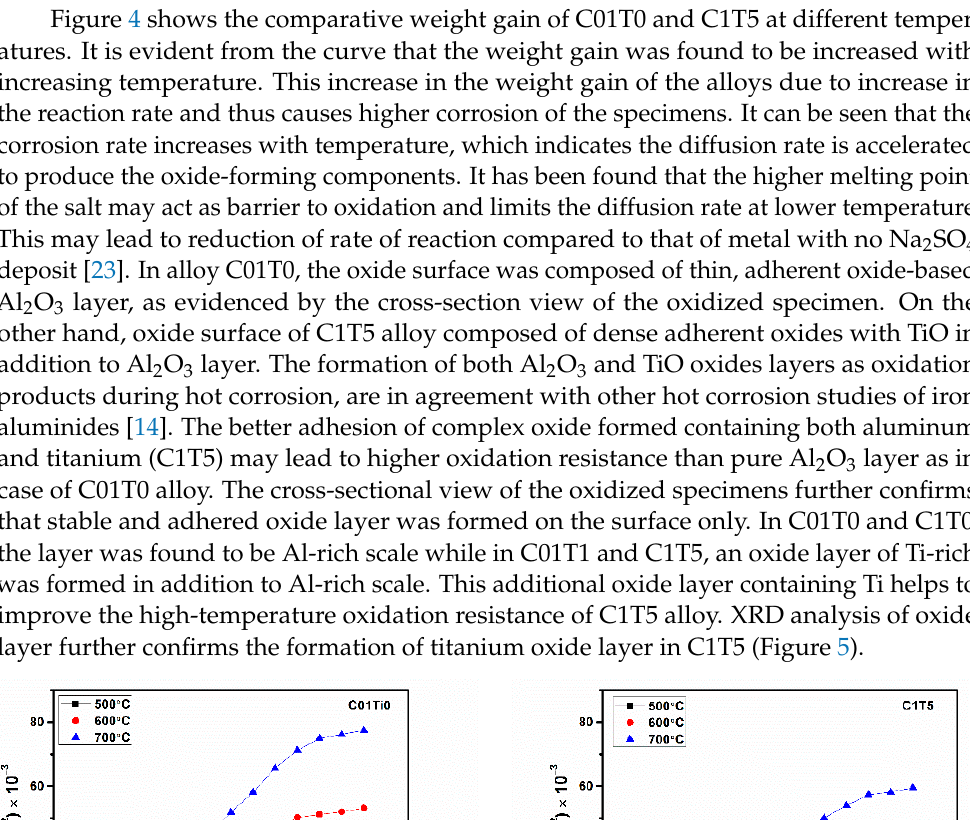
Figure 5. X-ray diffraction (XRD) patterns of oxidized samples. In molten salt (80%V 2 O 5 /20%Na 2 SO 4 ), the corrosion process takes place in two steps i.e., oxidation of the alloy, and then decomposition of the protective oxides deposits which can occurs either by basic or acidic reactions by the molten salt [24]. The reaction occurs may result the formation of oxide film by consumption of oxide ions in the melt and may release the complex ions. Now, in alloy with no titanium, their hot corrosion resistance depends upon the formation of Al 2 O 3 layer on the alloy surface only. However, with the presence of titanium in the alloy, there is an establishment of additional layer on the alloy surface. This would help to increase the compactness of the oxide layer and thus increases the corrosion resistance of the alloy. Further, more the aluminum (Al) or titanium (Ti) contents, thicker would be the oxide layer and thus, corrosion resistance of the alloy im- proved. For alloy without titanium i.e., C01T0 and C1T0 which forms only Al 2 O 3 oxide layer, have lower compactness (Figure 6a) and may undergo dissolution of the oxide layer more rapidly at metal/melt interface and thus, leads to more weight gain. On the other hand, Ti-containing alloys more compact and adhere oxide layer is formed which reduces the dissolution rate and thus, decreases the rate of weight gain.